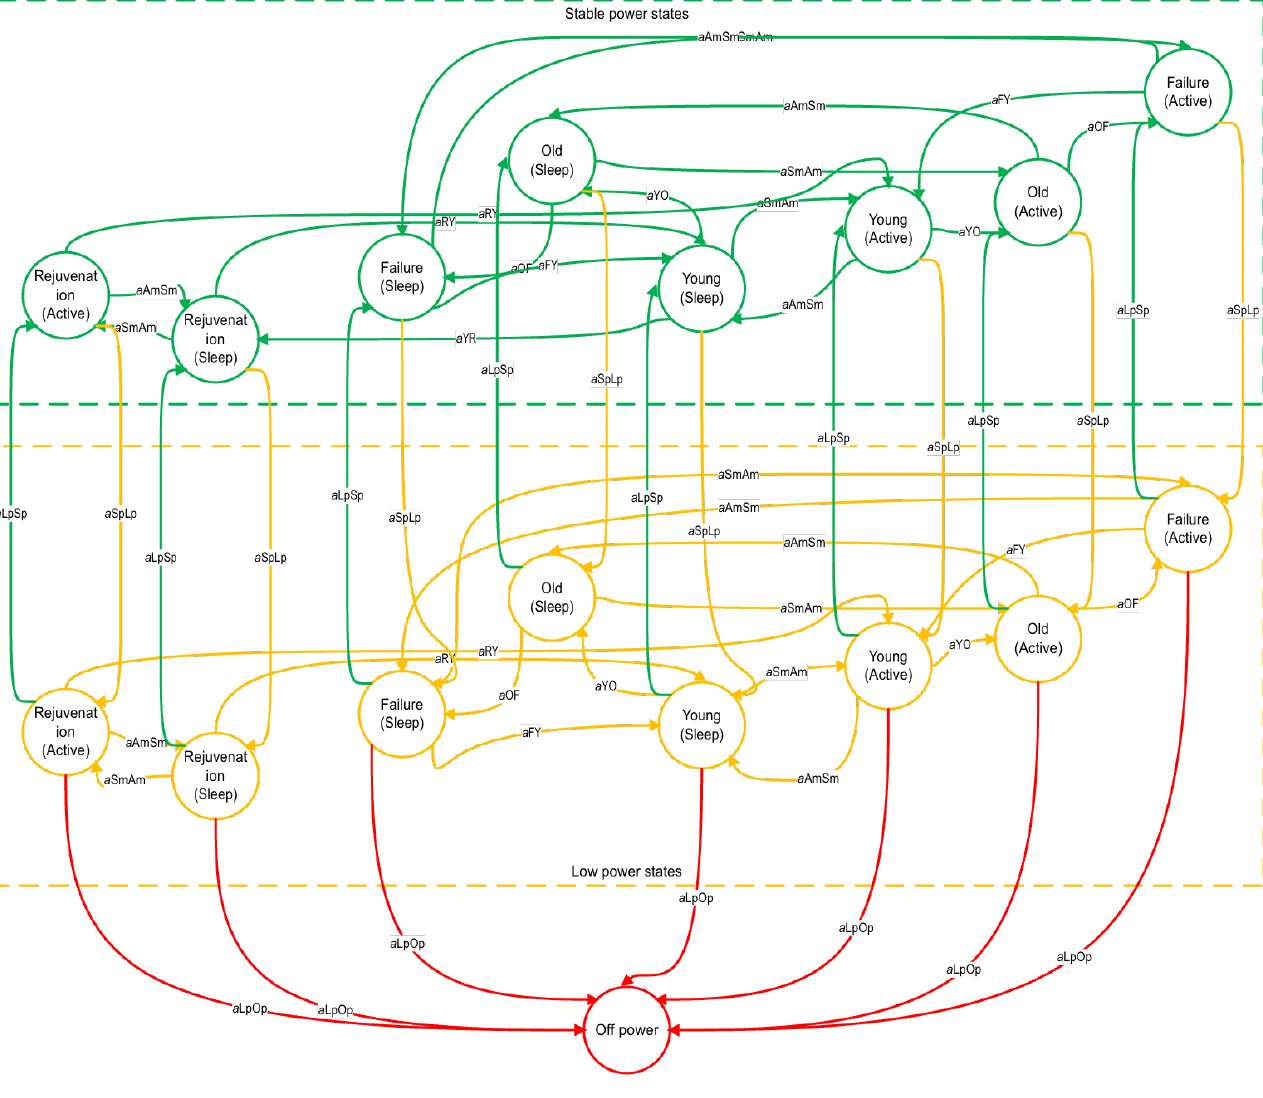
Figure 4. Graph of states and transitions of the software aging and rejuvenation model considering the battery charge level [25].